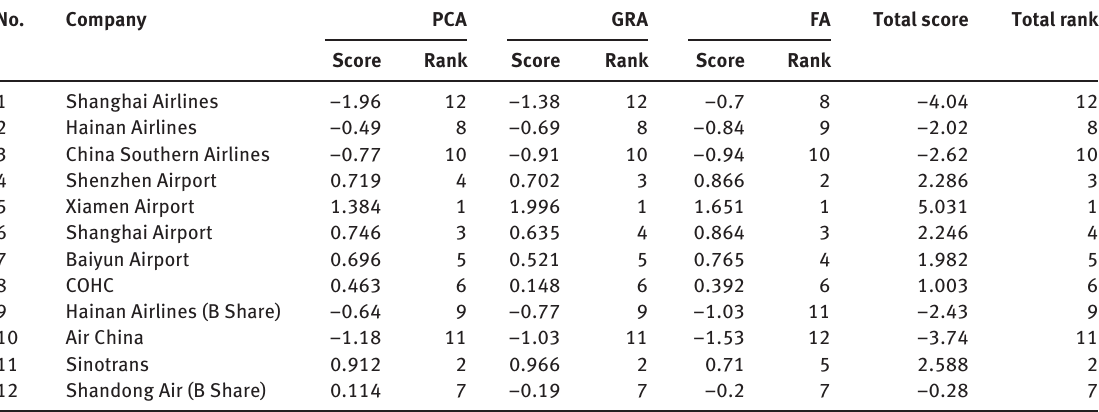
Table 4. The Scores and Ranks in PCA, GRA, and FA.